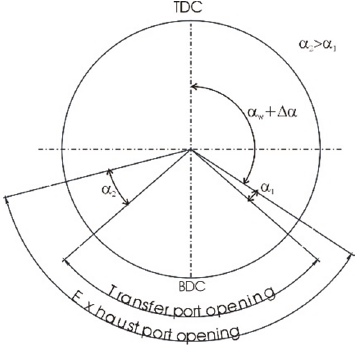
Fig. 4. Asymmetric phase timing in 2sOPE (delay of exhaust ports opening) Earlier opening of the exhaust port relative to the sym- metric timing causes also earlier closing of this port. The